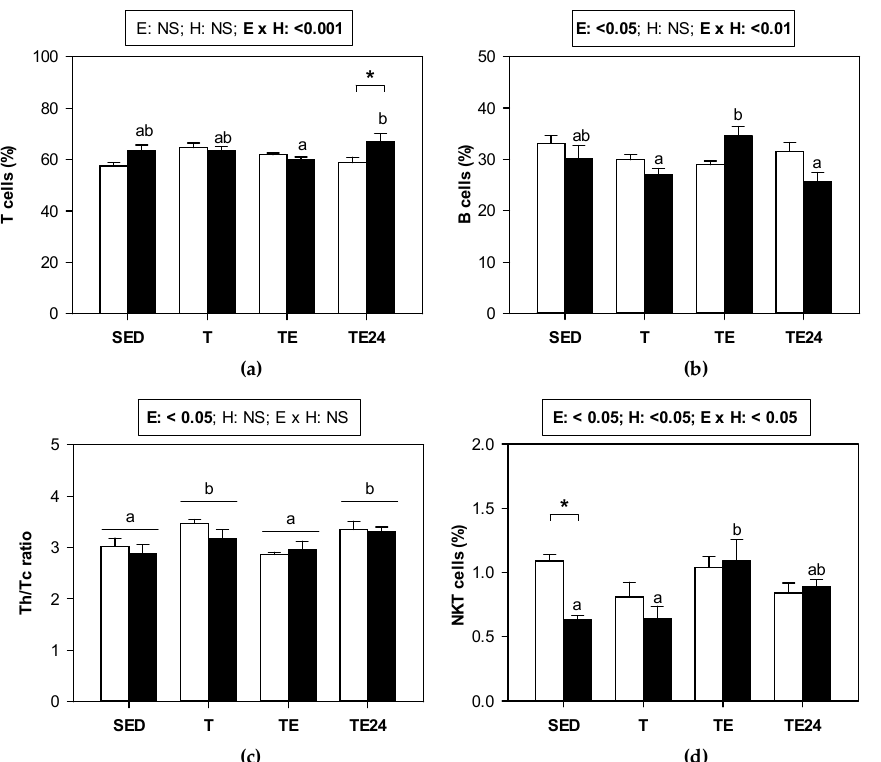
Figure 4. Proportion of the main lymphocyte populations in MLNs: ( a ) T cells, ( b ) B cells, ( c ) Th/Tc ratio, and ( d ) NKT cells. The non-supplemented groups are represented by white bars and the hesperidin-supplemented groups by black bars. SED = sedentary groups; T = trained groups; TE = T groups with an additional exhaustion test; TE24 = TE groups 24 h after the exhaustion test. E = exercise; H: hesperidin supplementation; E × H = interaction between E and H; NS = no significant differences. Data are expressed as mean ± SEM ( n = 8). When E × H interaction was significant, Tukey’s post hoc test was carried out, and changes between particular groups are represented with different letters above those groups that showed different results, and changes due to hesperidin supplementation are represented with an asterisk.